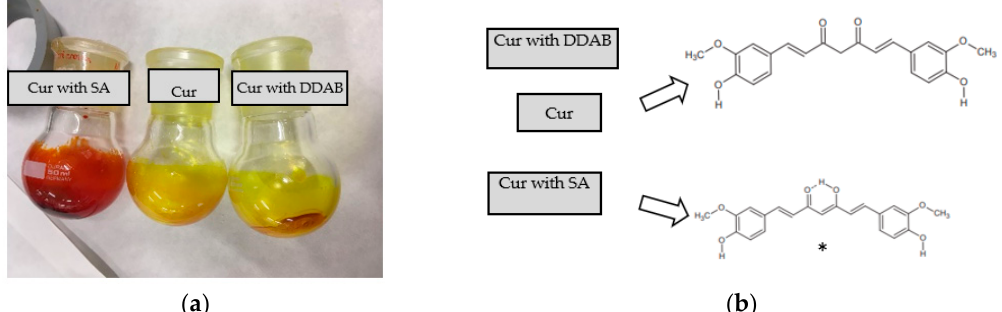
Figure 1. ( a ) Lipid films containing EPC, cholesterol (Cho), and Cur with an additional cationic agent: stearylamine (SA) or DDAB after removing the organic solvents methanol and chloroform. From left to right: lipid film containing Cur, Cho, and SA; lipid film containing Cur and Cho; lipid film containing Cur, Cho, and DDAB. ( b ) Chemical structures of Cur in the presence of SA or DDAB (Source: www.pubchem.ncbi.nlm.nih.gov).